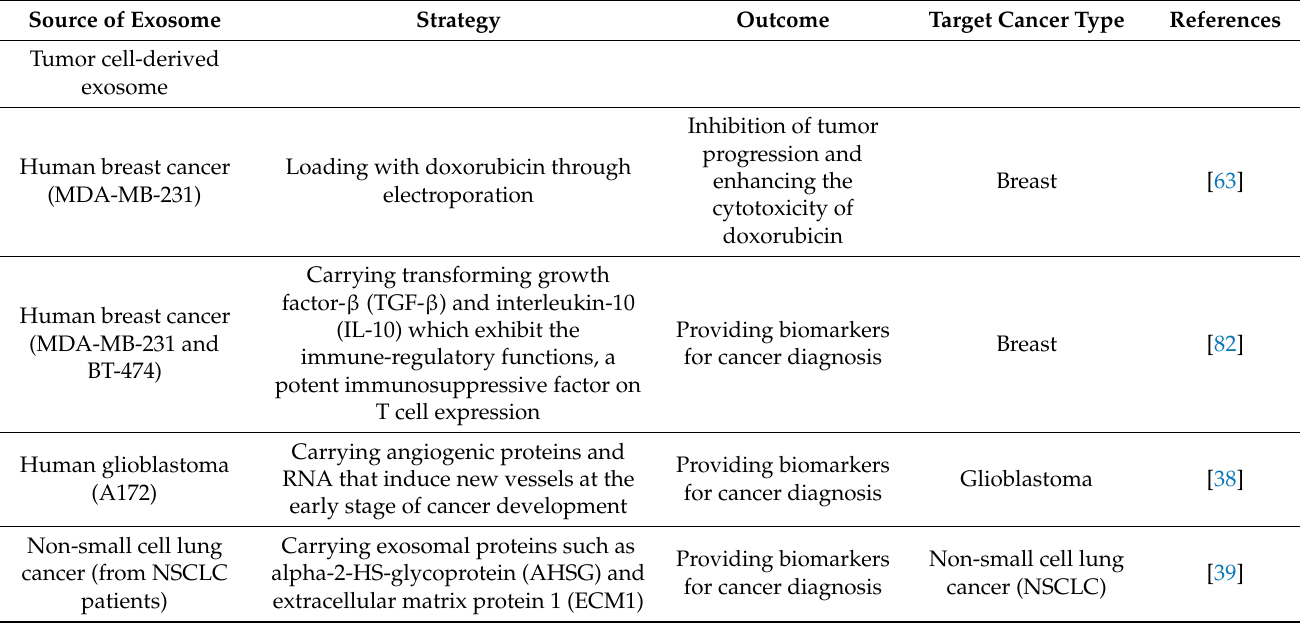
Table 2. Summary of studies using exosomes for cancer